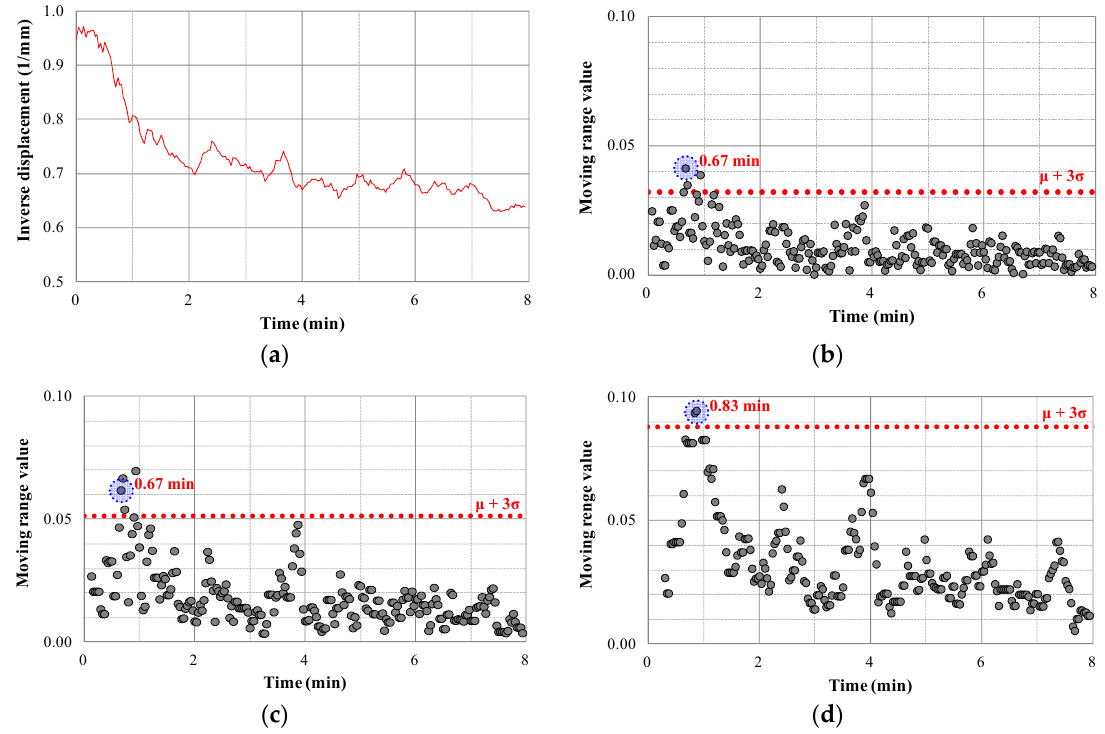
Figure 11. x–MR control chart method for displacement data of case 1 (moving average = 10 points): ( a ) Inverse displacement data (moving average = 10 points); ( b ) Moving range (K = 3); ( c ) Moving range (K = 5); ( d ) Moving range (K = 10).